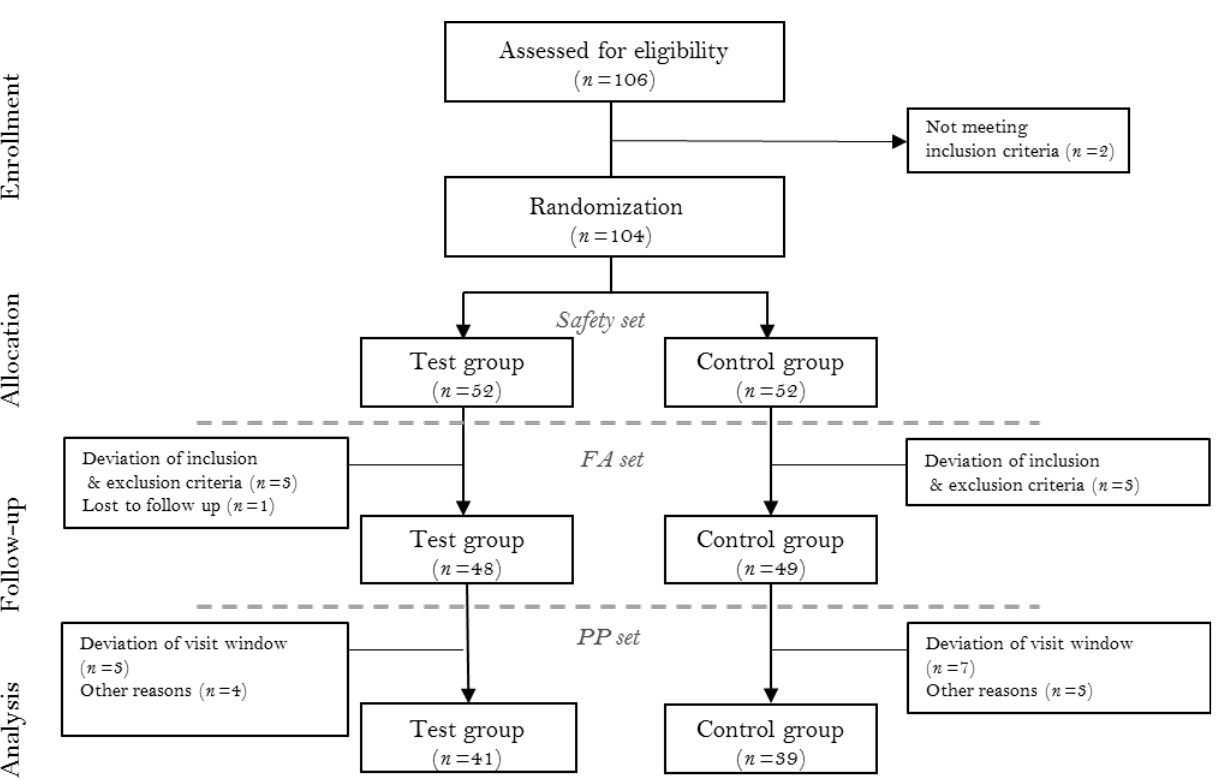
Figure 1. The CONSORT flow chart. FA (full analysis) set, and PP (per protocol) set.